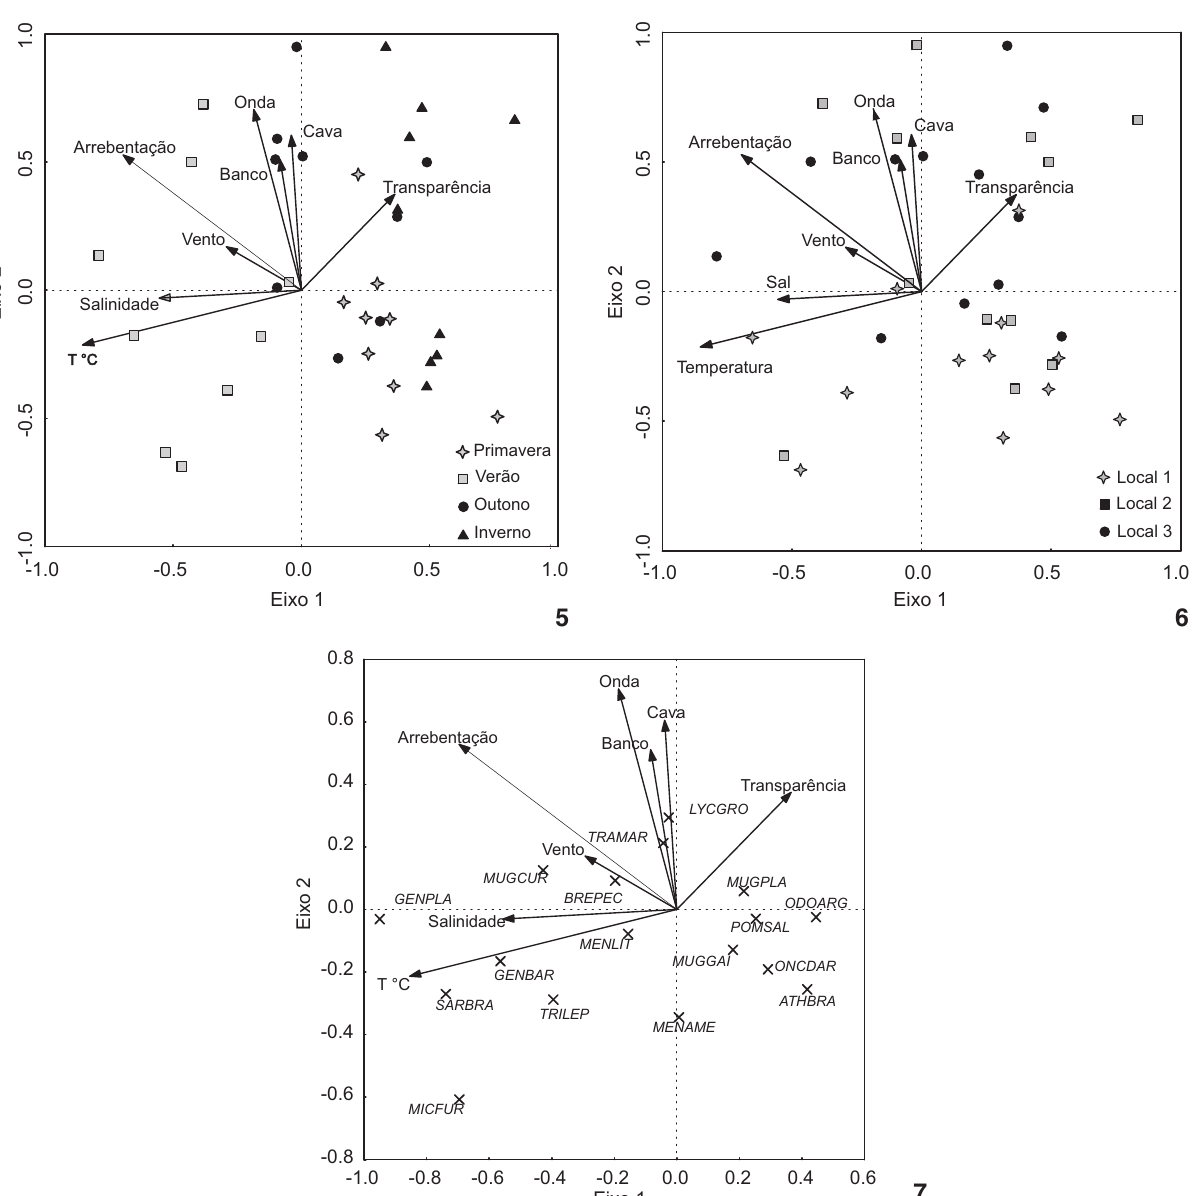
praia são caracterizados como uma área abrigada da ação das ondas e correntes de leste e nordeste (C ALLIARI et al. 2001). Os molhes da Barra da Lagoa dos Patos funcionam tam- bém como a única via de conexão entre o estuário da Lagoa dos Patos e o oceano (C HAO et al. 1982), o que influencia a